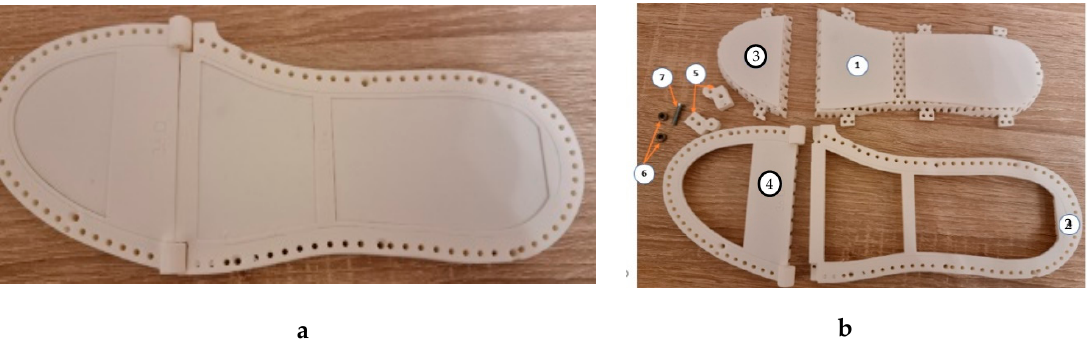
Figure 3. Sandal sole—Solidworks design: ( a ) inside view of the sole; ( b ) exterior view sole; ( c ) the elements of the sole: 1—heel sole; 2—heel sole frame; 3—toe sole; 4—toe sole frame.